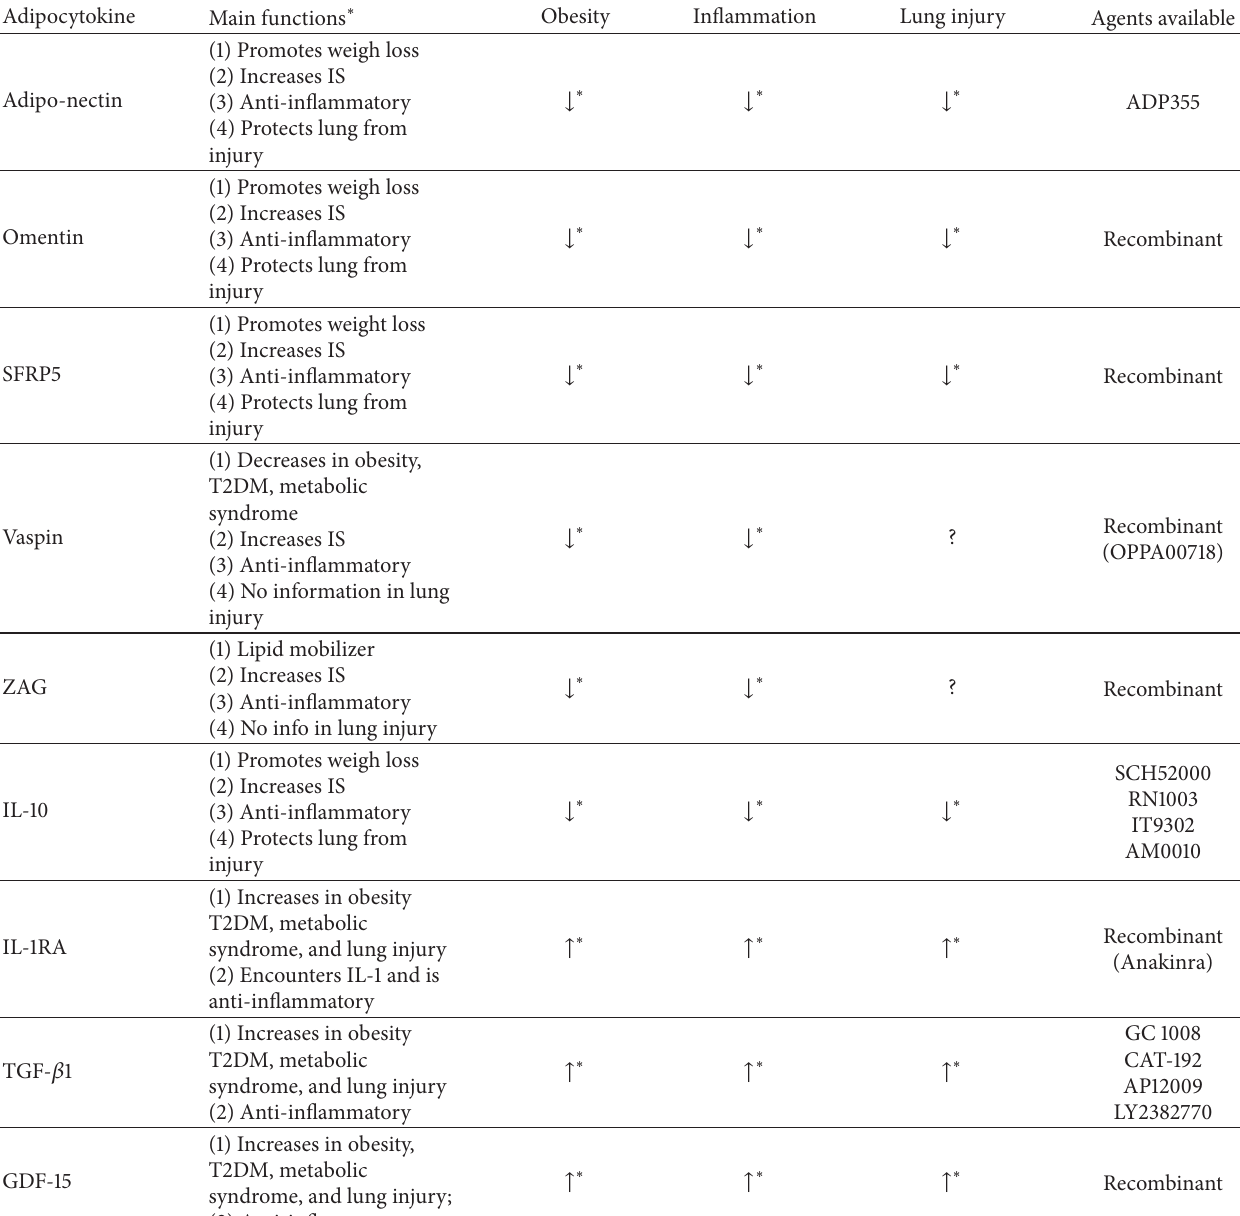
Table 1: Adipocytokines in obesity, inflammation, and lung injury: the good